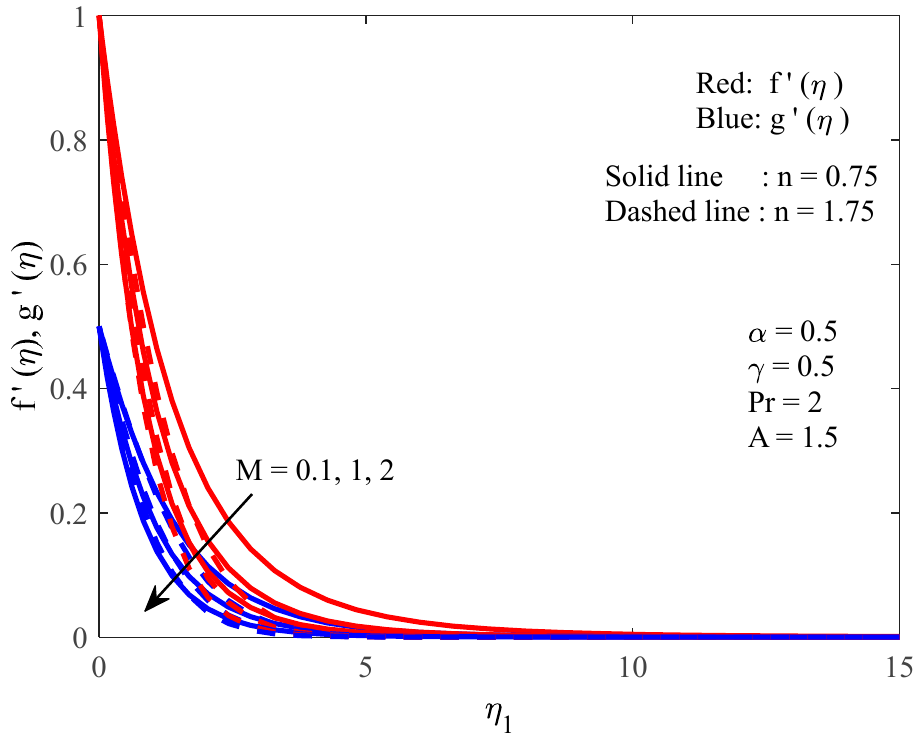
Energies 2023 , 16 , 3183